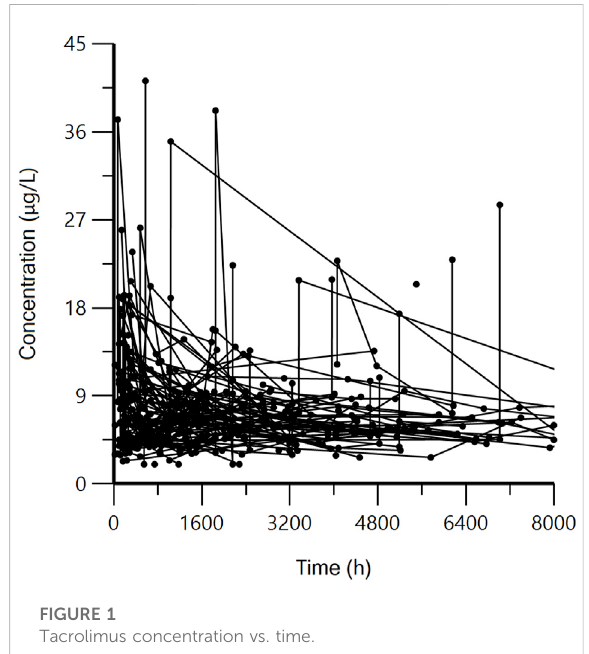
FIGURE 1 Tacrolimus concentration vs. time.